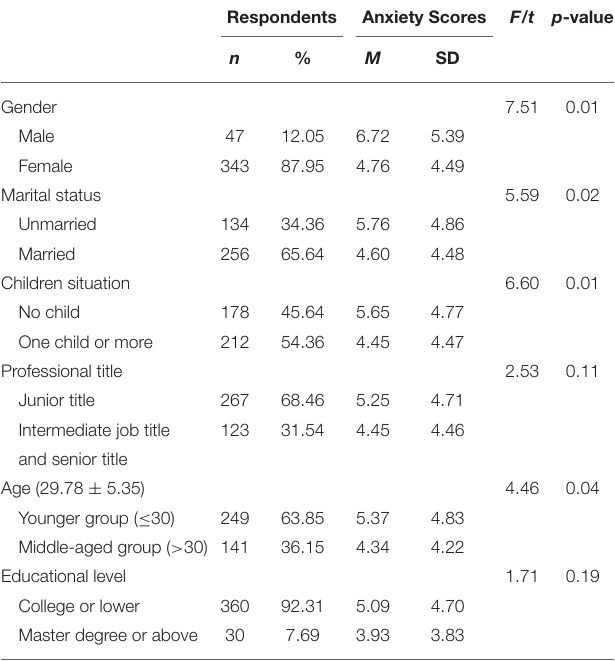
TABLE 1 | Demographic characteristics of respondents ( N = 390) and group comparisons on anxiety.